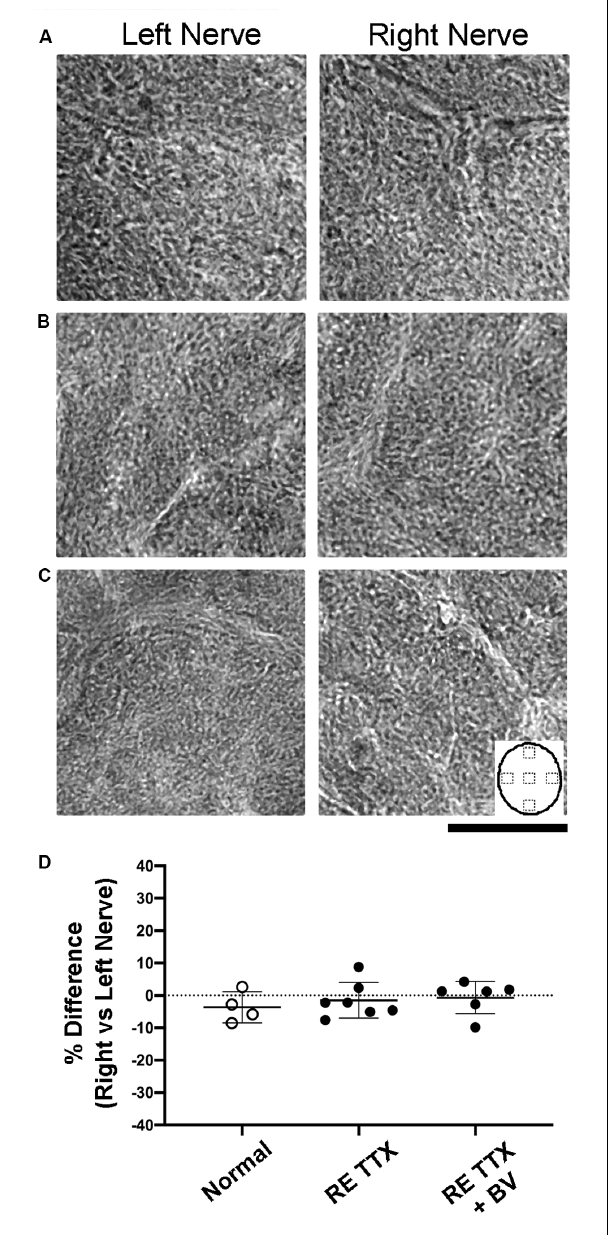
FIGURE 4 | Cross-sections of the optic nerve from the left and right eye stained with luxol blue to evaluate myelin levels. In normal animals (A) no difference in myelin staining was observed between the left and right optic nerves. Myelin staining following right eye inactivation was likewise similar between left and right optic nerves and was comparable to normal immediately after 10 days of inactivation (B) or after inactivation wore off (C) . Quantification of myelin staining from sample locations of optic nerve cross-sections (inset in C ) revealed a balance in staining intensity across the left and right optic nerves (D) that was not statistically different between groups ( H = [3] = 0.95, p = 0.64; Dunn’s multiple comparison test: p > 0.05). Scale bar = 250 microns. conditions ( Figure 6D ). Across the three groups studied, there was no statistical difference in GFAP